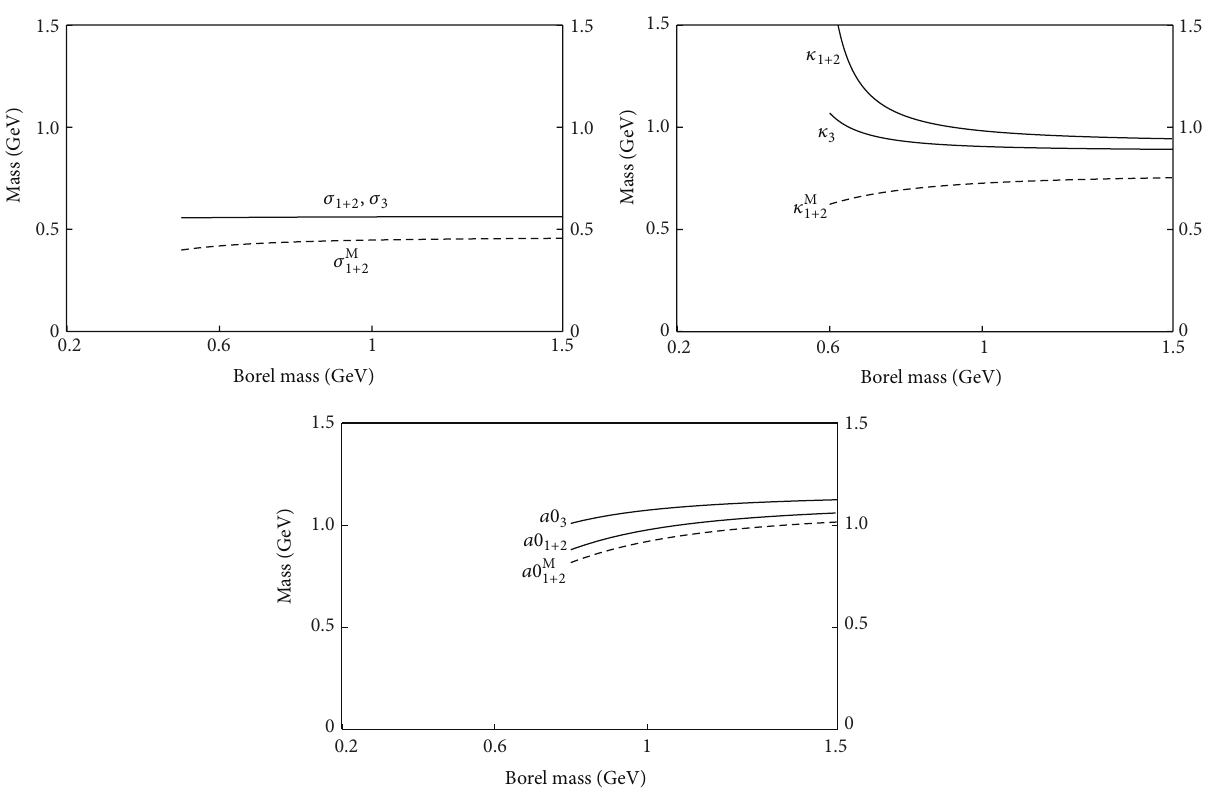
Figure4:Massoflightscalarmesons 𝑓 0 (500) , 𝜅(800) ,and 𝑎 0 (980) ( 𝑓 0 (980) )asfunctionsofBorelmass 𝑀 𝐵 .Thethresholdvalues 𝑠 0 for 𝑓 0 (500) , (980) ( 𝑓 (980) ) are chosen to be 0.40 , 0.90 , and 1.80 GeV 2 , respectively. The solid curves are obtained using the tetraquark 𝜅(800) , and 𝑎 0 0 currents 𝜎 1+2 , 𝜎 3 , 𝜅 1+2 , 𝜅 3 , 𝑎0 1+2 , and 𝑎0 3 (see definitions in (23), (24), (25), and (26)), while the dashed curves are obtained using the modified currents 𝜎 mod 1+2 , 𝜅 mod 1+2 , and 𝑎0 mod 1+2 (see definitions in (35)). The results for 𝑓 0 (980) are the same as those for 𝑎 0 (980) .